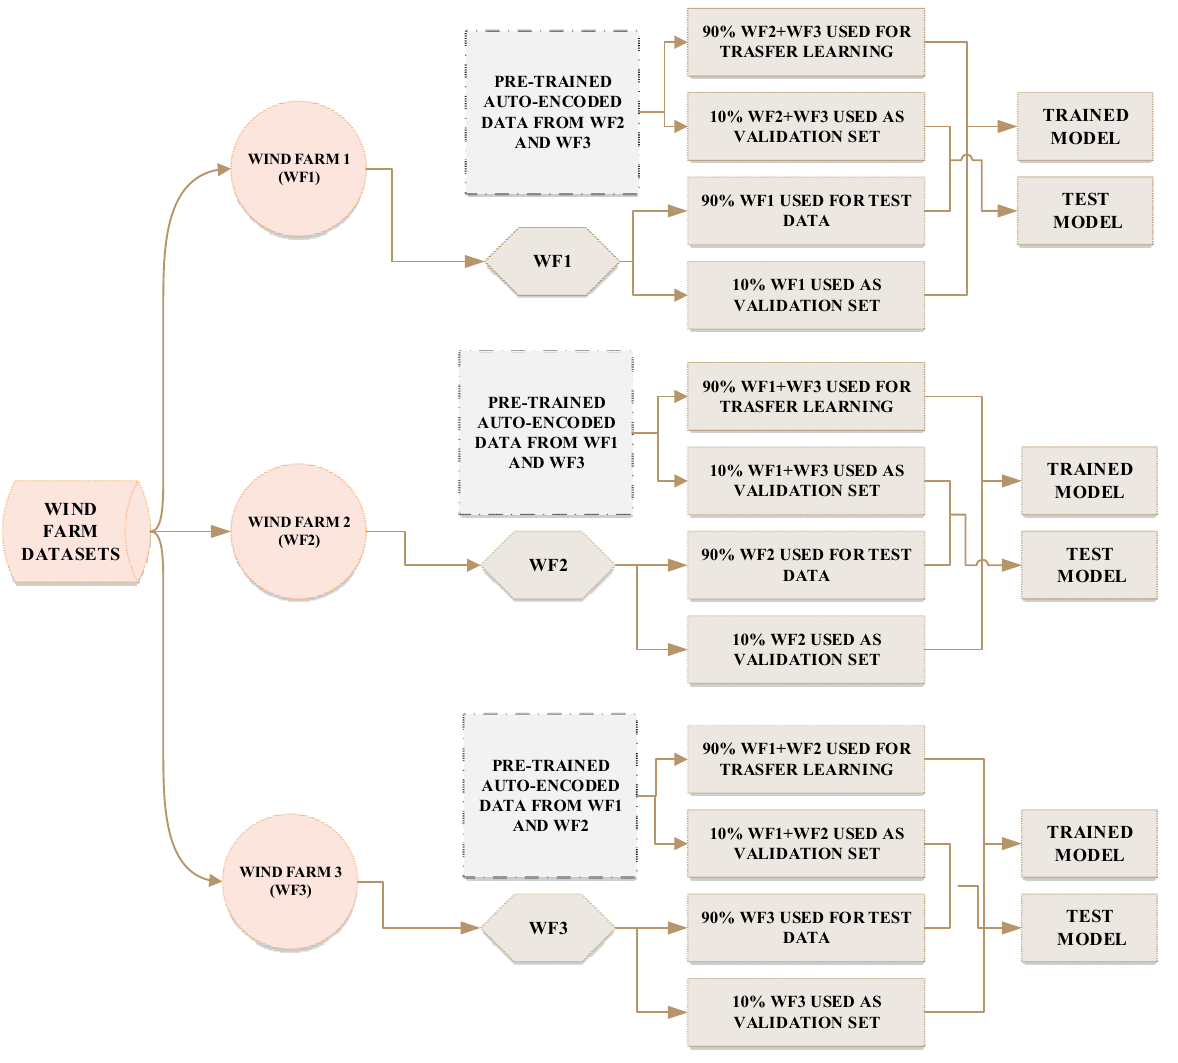
Figure 3. Three windfarm dataset selection and distribution to train and test the deep learning models.